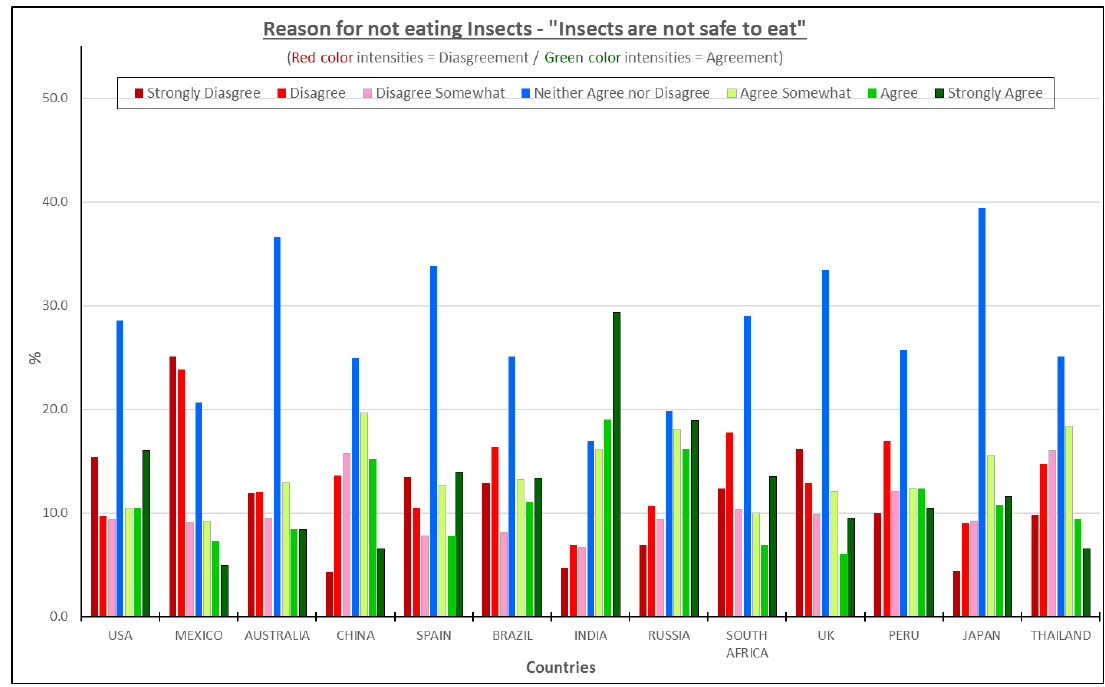
Figure 6. The reasons for not eating insect products—“Insects are not safe to eat”.